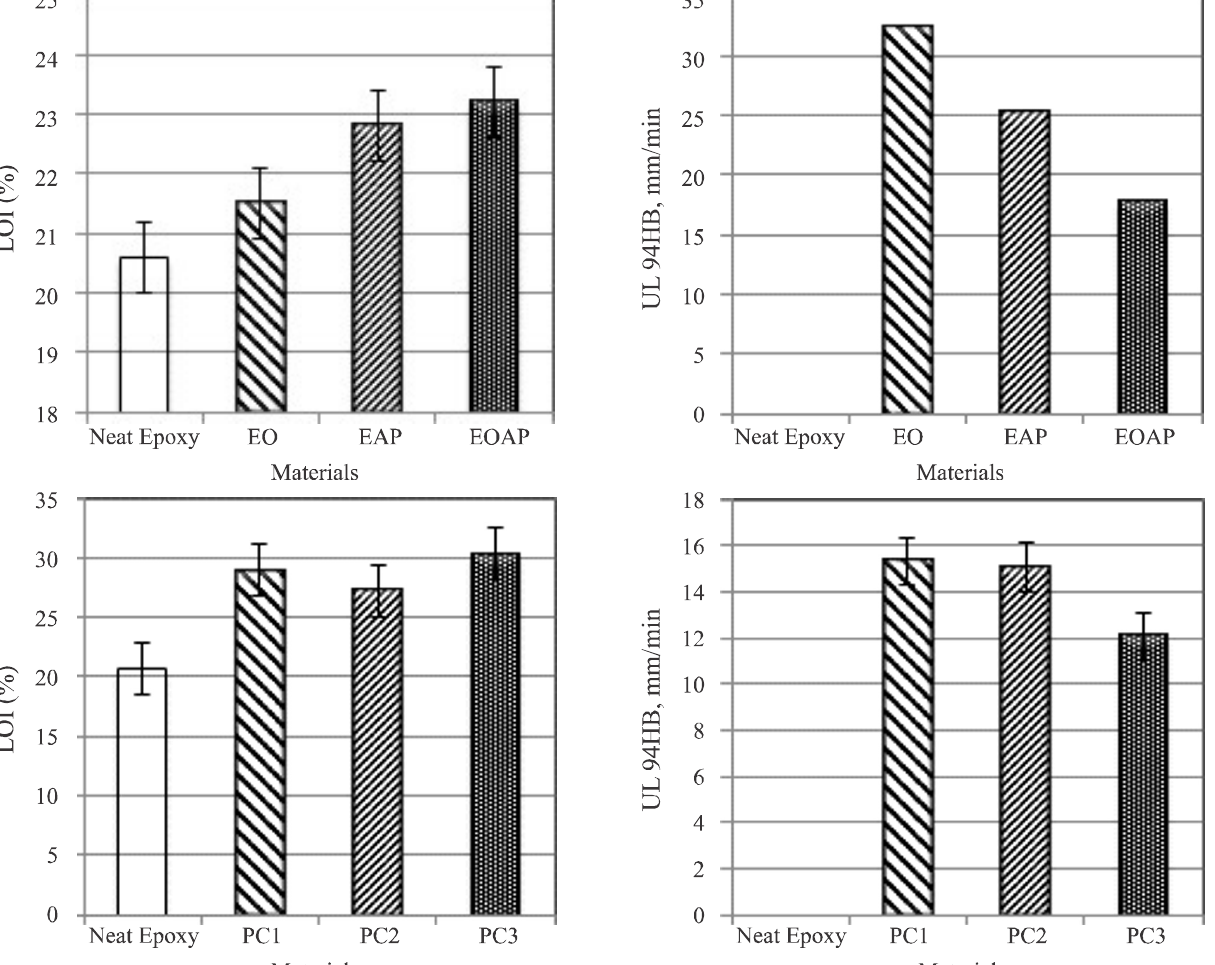
FIG. 11. MECHANICAL STRENGTH OF POLYMER EPOXY MATERIALS: NEAT EPOXY; EPOXY/ EPOXIDIZED LINSEED OIL (EO);